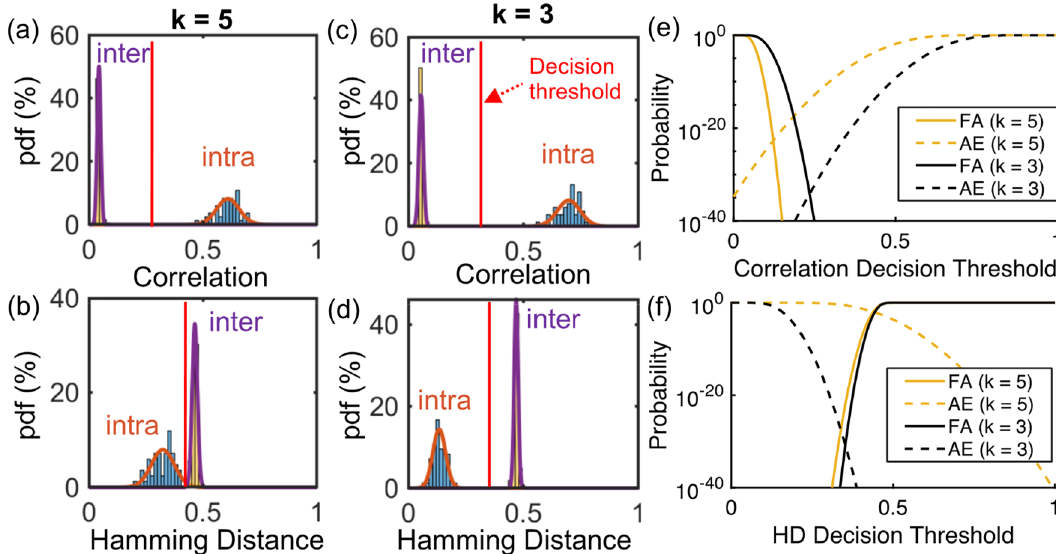
Figure 3. ( a ) Correlation-based authentication with k = 5, ( b ) HD based authentication with k = 5, ( c ) correlation-based authentication with k = 3, ( d ) HD based authentication with k = 3. Cumulative distribution functions indicating the probabilities of false authentication (FA) or authentication error (AE) as a function of decision threshold for ( e ) correlation based and ( f ) HD based